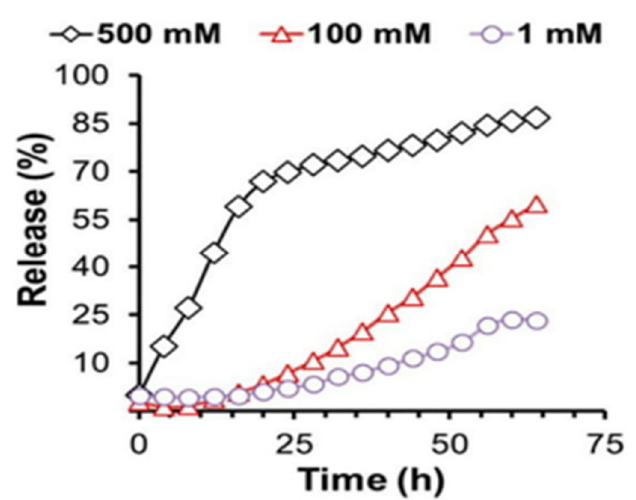
Figure 6. Drug release dependent on Reactive Oxygen Species concentration as displayed by PPS 60- b-PDMA 150-b-PNIPAAM150 triblock polymer-based thermos-responsive Nile red-loaded hydrogels. Nile red-loaded hydrogels (5 wt% triblock copolymer concentration) in PBS (pH 7.4) have been used to demonstrate Hydrogen Peroxide dependent drug release kinetics in vitro at 37 ◦ C. 1, 100 and 500 mM concentrations of H 2 O 2 over a 64 h time course were incubated with the hydrogel samples to study ROS dependent drug release (reprinted (adapted) with permission from [31]; copyright (2014) American Chemical Society).